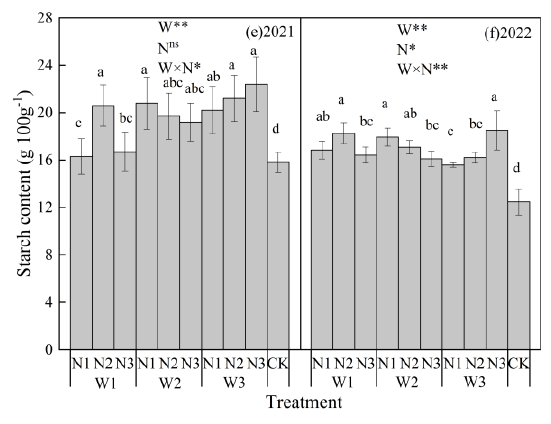
Figure 6. Effect of different water and nitrogen levels on quality regulation. Note: ( a ) for potato vitamin C content in 2021, ( b ) for potato vitamin C content in 2022, ( c ) for potato reducing sugar content in 2021, ( d ) for potato reducing sugar content in 2022, ( e ) for potato starch content in 2021, and ( f ) for potato starch content in 2022. * and ** indicate p < 0.05 and p < 0.01, respectively; ns indicates that there was no significant effect ( p > 0.05). N is the nitrogen application rate, and W is the irrigation quota.